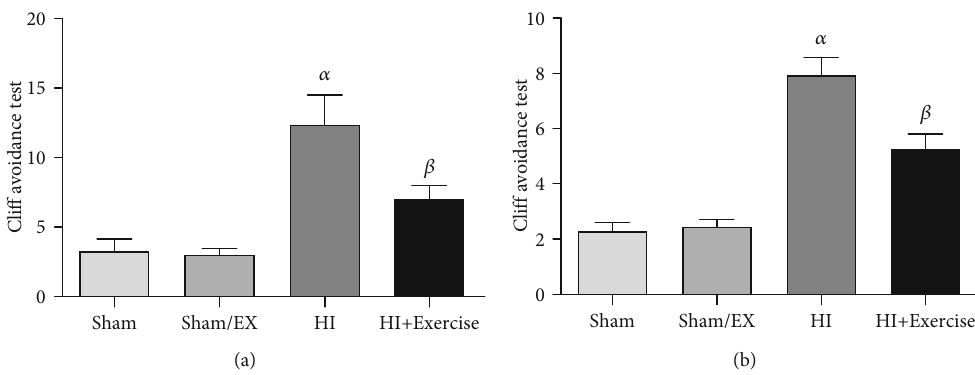
Figure 10: Cli ff avoidance test of male (a) and female (b) in sham, HI, and HI/exercise groups. (a) α P < 0 : 05 , HI versus sham and sham/EX; ß P < 0 : 05 , HI/exercise versus HI. (b) α P < 0 : 001 HI versus sham and sham/EX; ß P < 0 : 05 , HI/exercise versus HI ( mean ± S : E : M ., n = 20